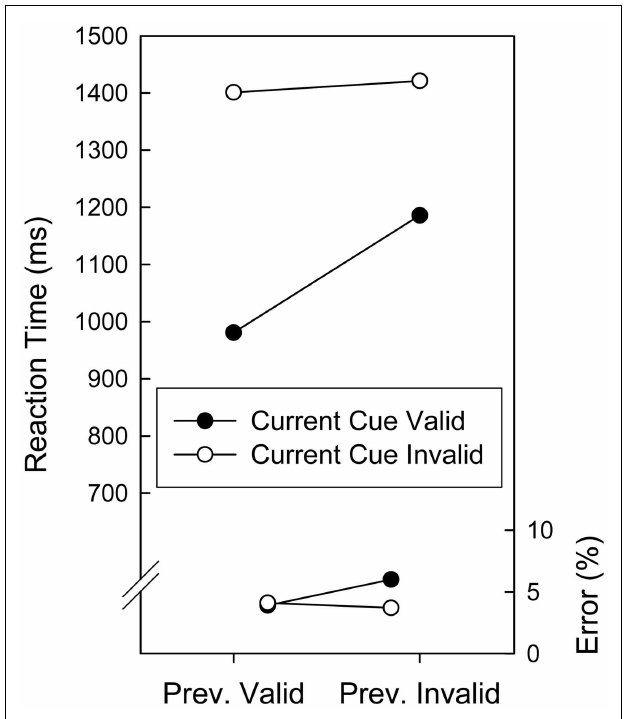
FIGURE 1 | Mean reaction times and error proportions of Experiment 1 as a function of cuing validity of the current and preceding trials.